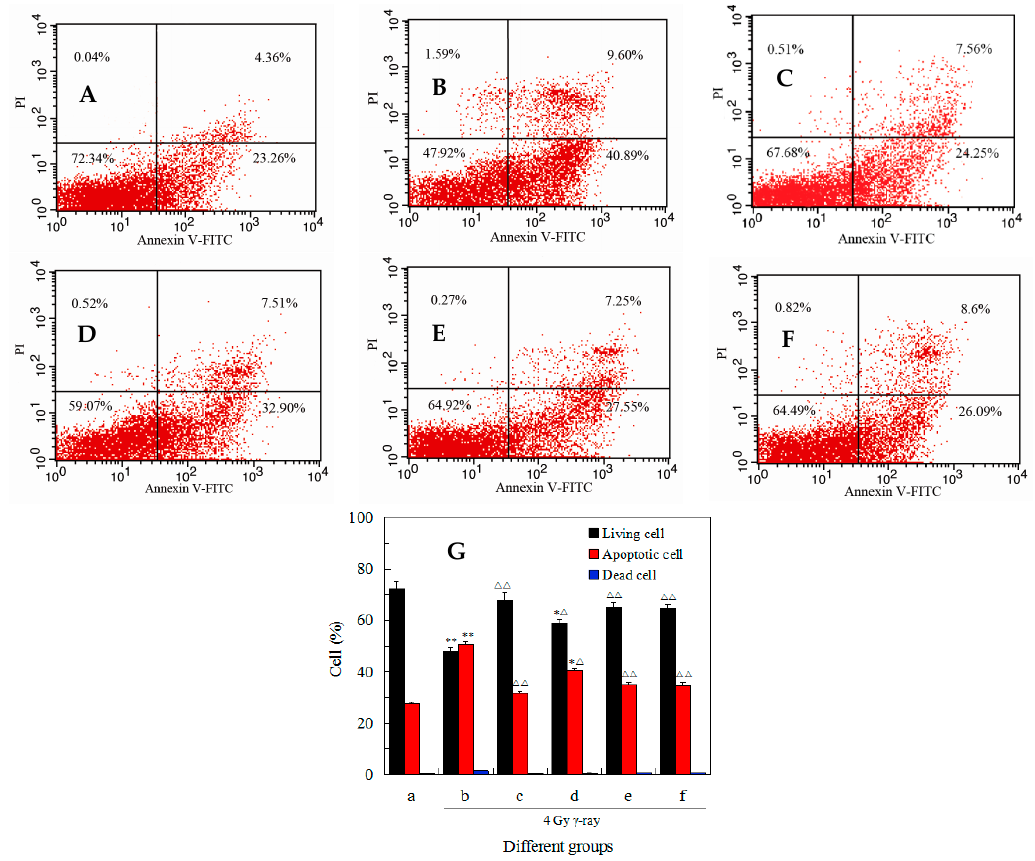
Figure 4. Determination of splenocyte apoptosis in different groups assessed by flow cytometry using